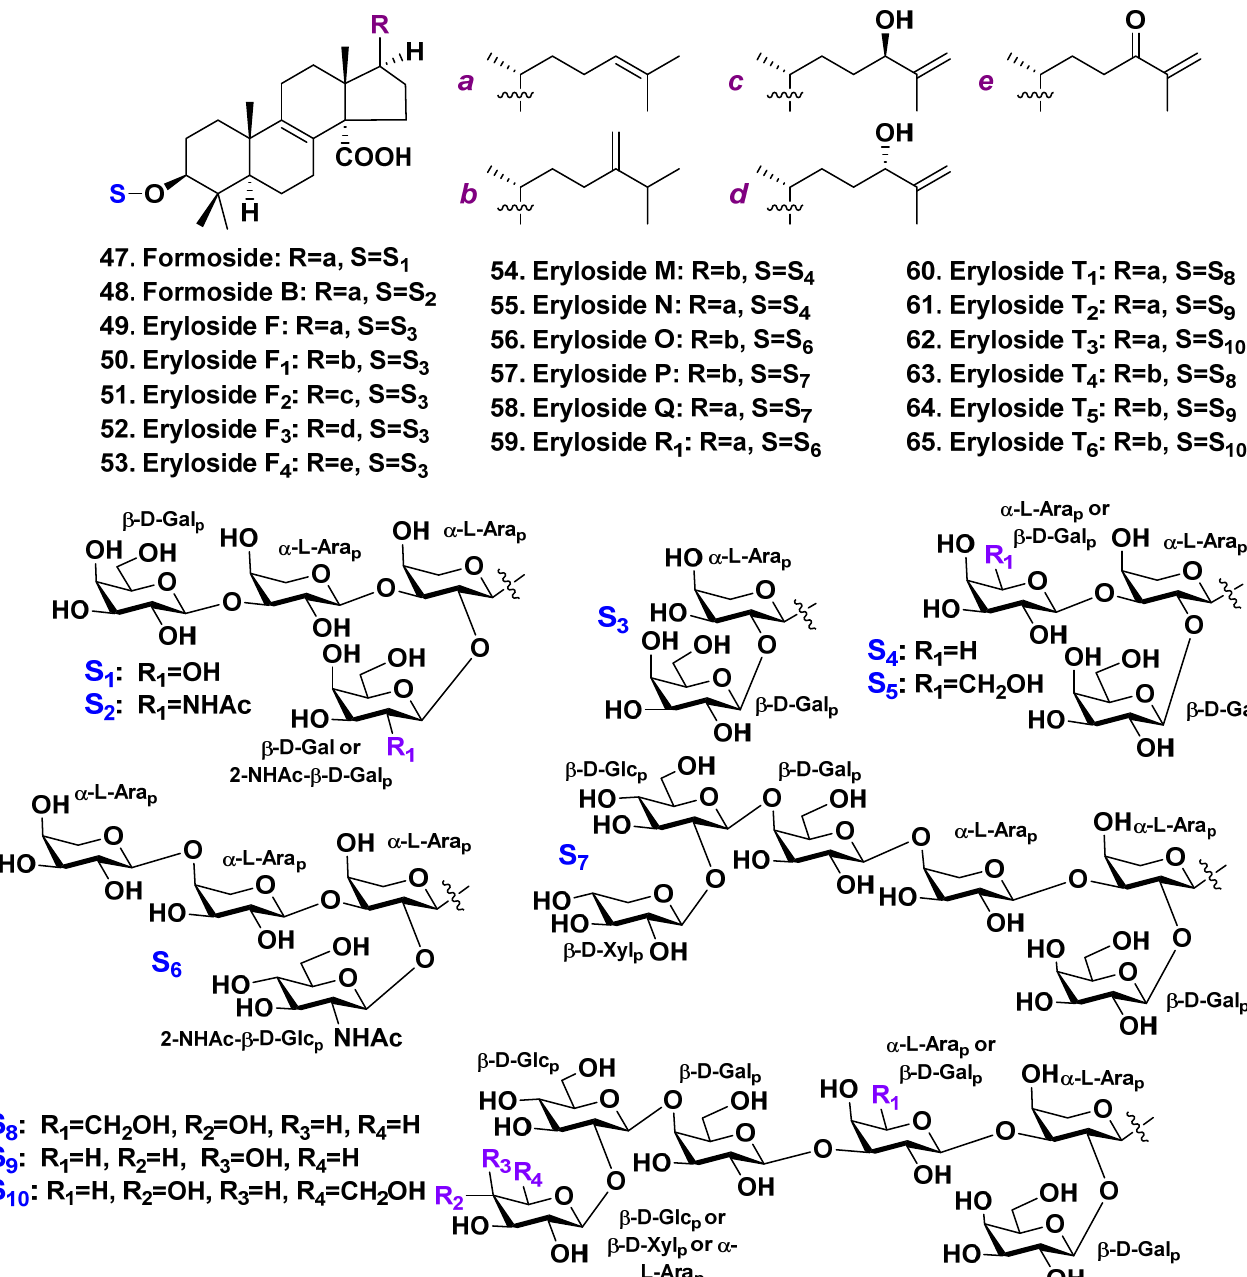
Figure 4. Erylosides 47 – 65 from Erylus formosus .